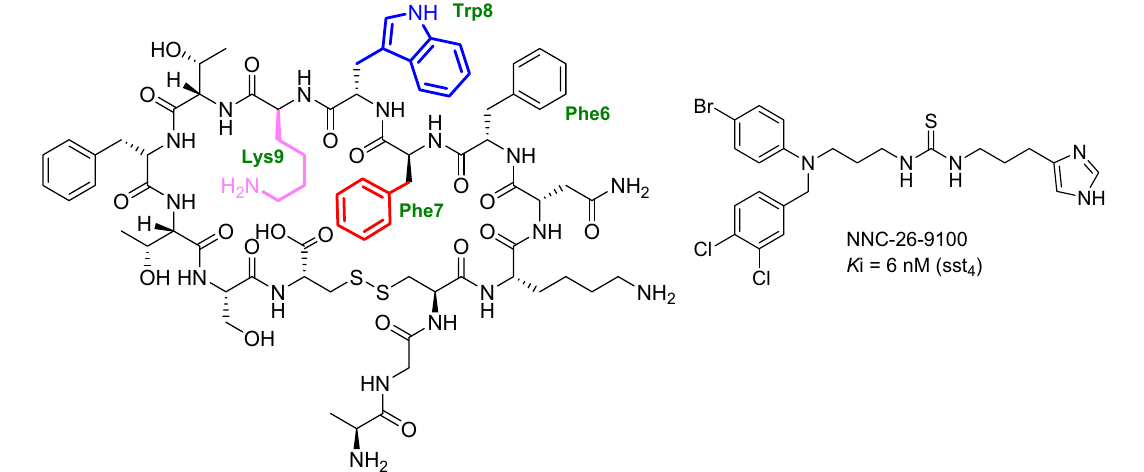
Fig. 1 Structures of somatostatin (somatotropin release-inhibiting factor, SRIF) and NNC 26–9100. SRIF is shown here as a tetradeca- peptide (SRIF-14), which is one of its two active forms. The disulfide bond at positions 3 and 14 helps stabilize the structure of SRIF-14. Trp8 and Lys9 are considered essential binding sites for all somato- statin receptors, whereas Phe6 is involved in sst